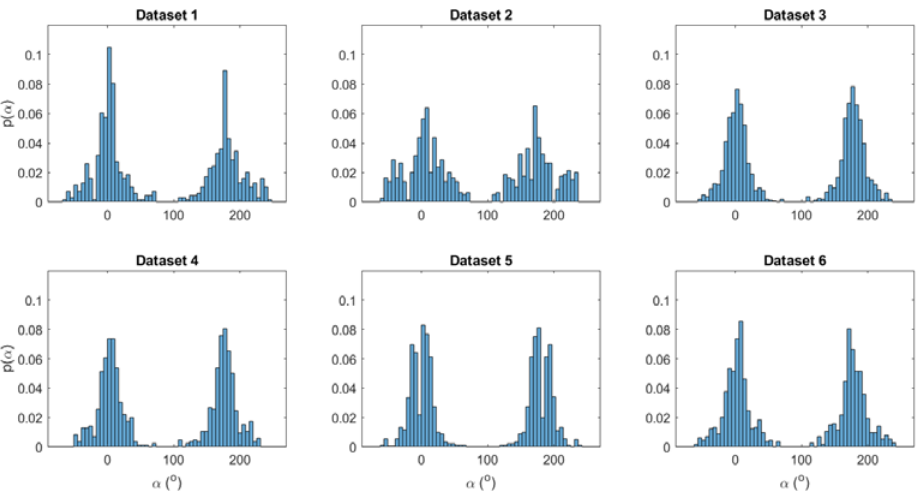
Figure 4. Histograms of elevation angle observations from six real TLS self-calibration datasets.